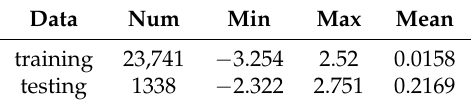
Table 1. The descriptive statistics of the NAO index